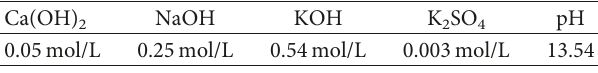
Table 4: Simulated pore solution of steel slag materials.